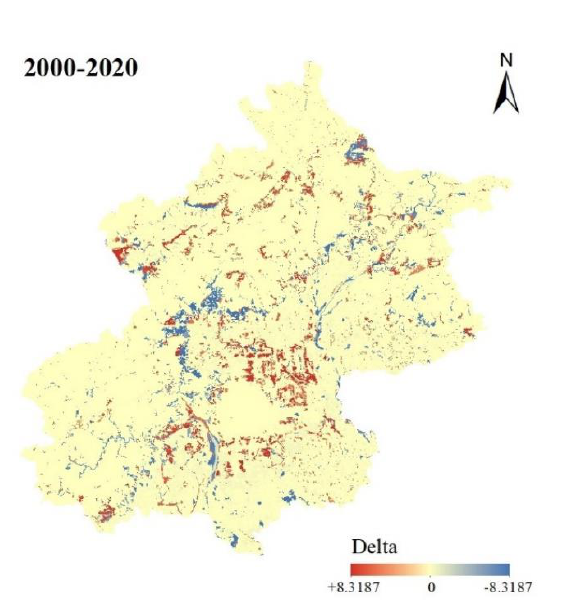
Figure 4 . Change of carbon storage between 2000 to